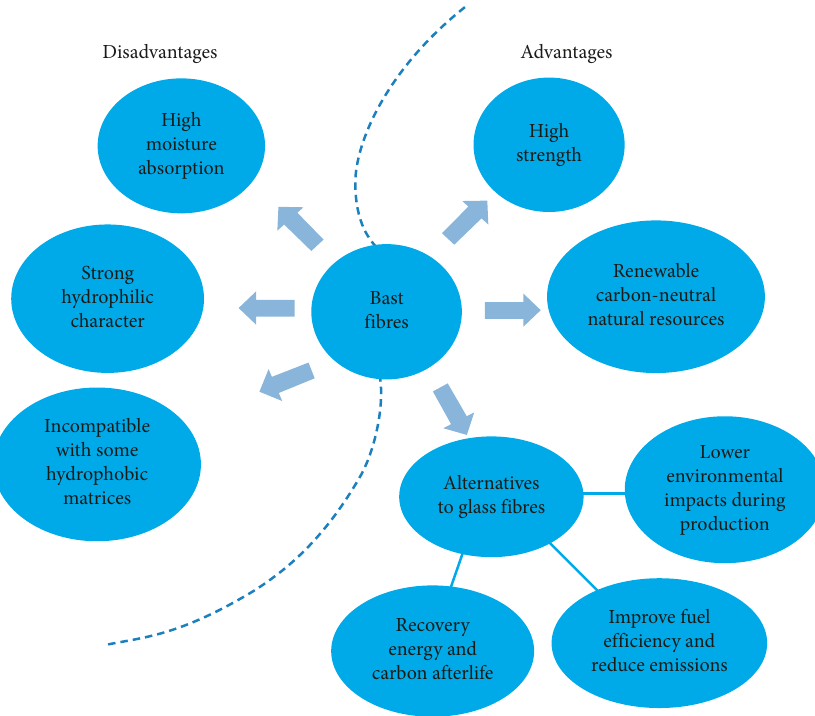
Figure 3: Advantages and disadvantages of bast fibres (source: [20, 21]). Table 1: Effect of PF physical treatment on the mechanical properties of composite materials.